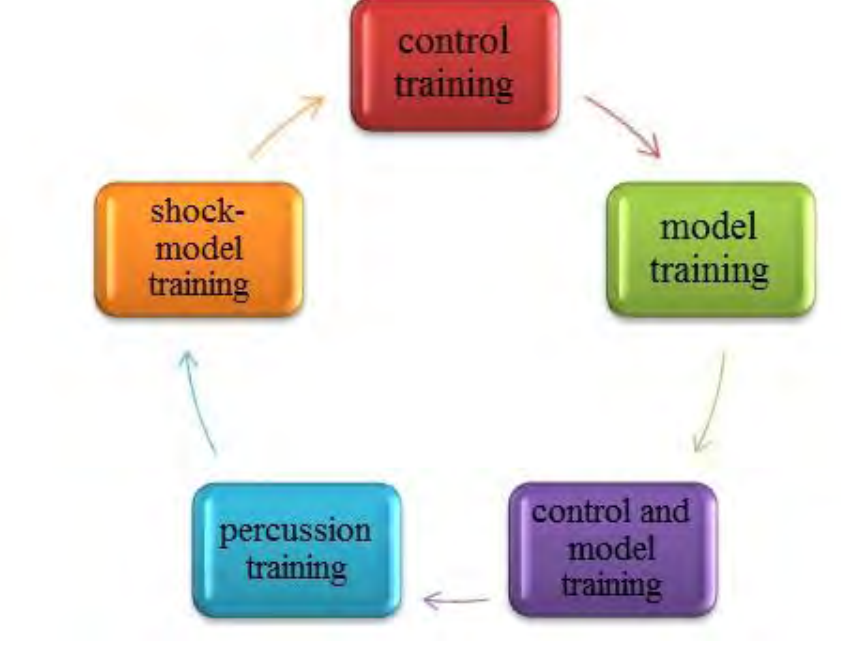
Fig. 3. Model micro cycles of inter-tour competition